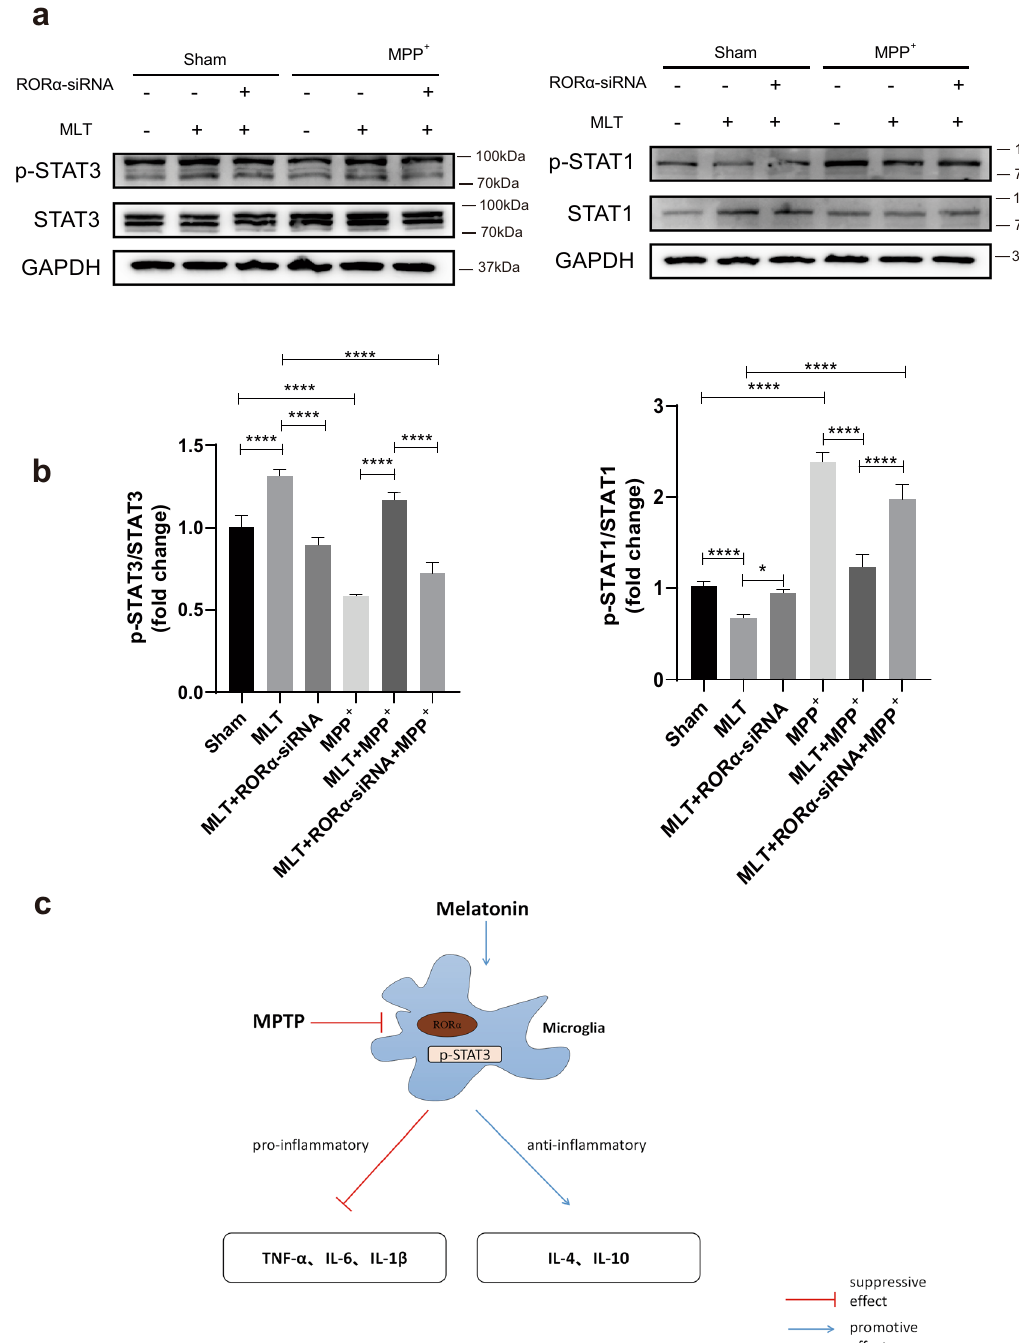
Fig. 6 MLT regulated the phenotypic change in microglia via ROR α -STAT pathway. a , b Immunoblot analysis of STAT1, STAT3, phosphorylated ‐ STAT1 and phosphorylated ‐ STAT3 in BV2 cells with MPP + , MLT and ROR α -siRNA treatment alone or in combination for 24 h with GAPDH as a loading control. Fold change was calculated by Image J . Data were average with error bars representing standard deviation. ( n = 3 independent experiments. * P < 0.05; **** P < 0.0001). c Assumed mechanism for the anti-in fl ammatory effect of melatonin via ROR α against